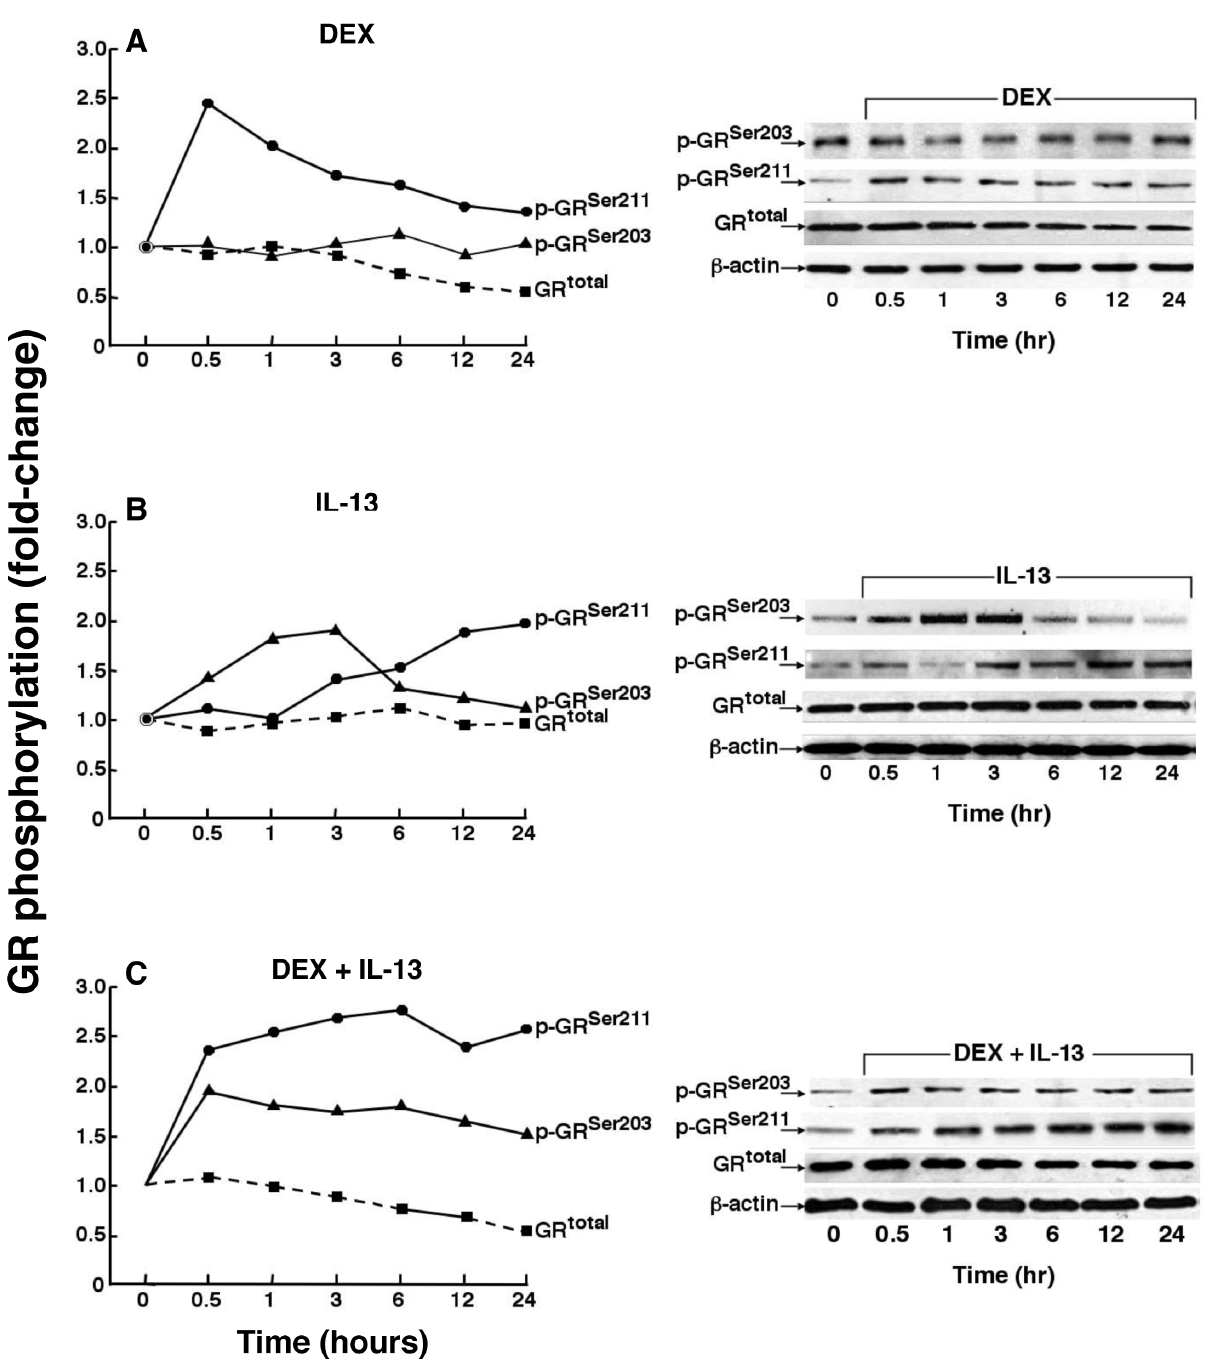
Figure 4. Comparison of induced temporal changes in site-specific GR phosphorylation in HASM cells treated with DEX or IL-13 alone and in combination. Representative immunoblots from one of three experiments depicting that, nder basal conditions, relative to p- GR Ser211 , HASM cells exhibit distinctly increased p-GR Ser203 levels. Contrasting the acute transient increase in p-GR Ser211 elicited by DEX treatment alone ( A ), HASM cells treated with IL-13 alone exhibit an initial increase in p-GR Ser203 followed by a progressive increase in p-GR Ser211 ( B ), whereas combined treatment with DEX + IL-13 evokes sustained increases in p-GR Ser203 and p-GR Ser211 for up to 24 h ( C ). Note, GR total levels are unaffected in HASM cells exposed to IL-13. By comparison, cells treated with DEX (alone or in combination with IL-13) exhibit progressive decreases in GR total levels. doi:10.1371/journal.pone.0060452.g004 was distinctly present in cells transfected with S211A mutant of GR Ser203 by IL-13 (Fig. 4B) is needed to enable subsequent GR construct. The observation that IL-13-induced GR Ser211 phos- phosphorylation at Ser 211 . Thus, these data are consistent with an phorylation is suppressed in cells transfected with the S203A earlier report implicating the presence of interdependence of GR construct suggests that the above depicted initial phosphorylation phosphorylation at the serine 203 and 211 sites [23]. Of note,